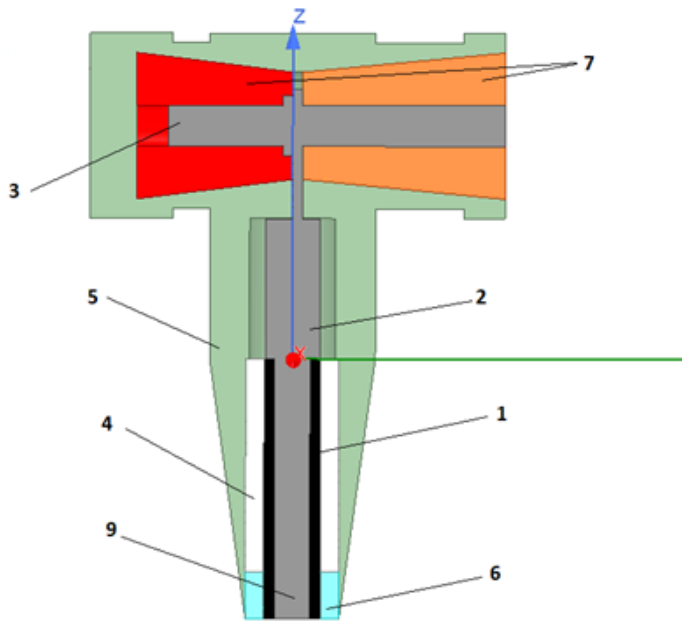
Figure 2. A 2D cross-section of the connector head in the ANSYS environment. A conductor